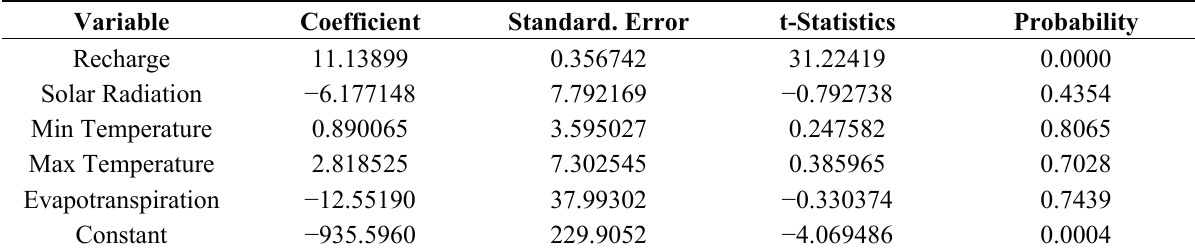
Table 4. Results from the Error Correction